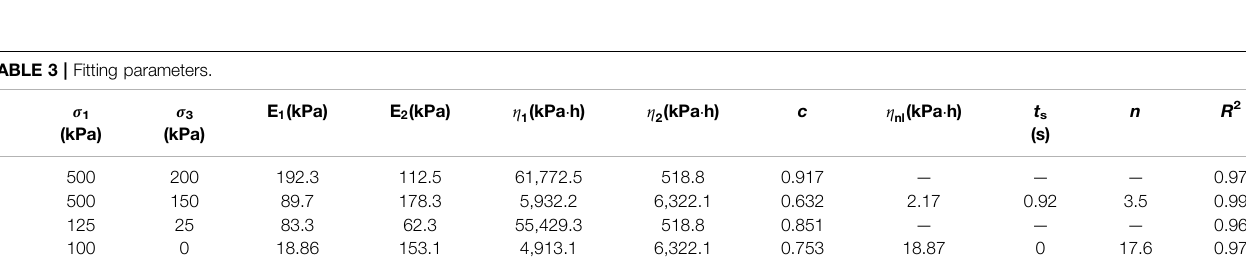
TABLE 3 | Fitting